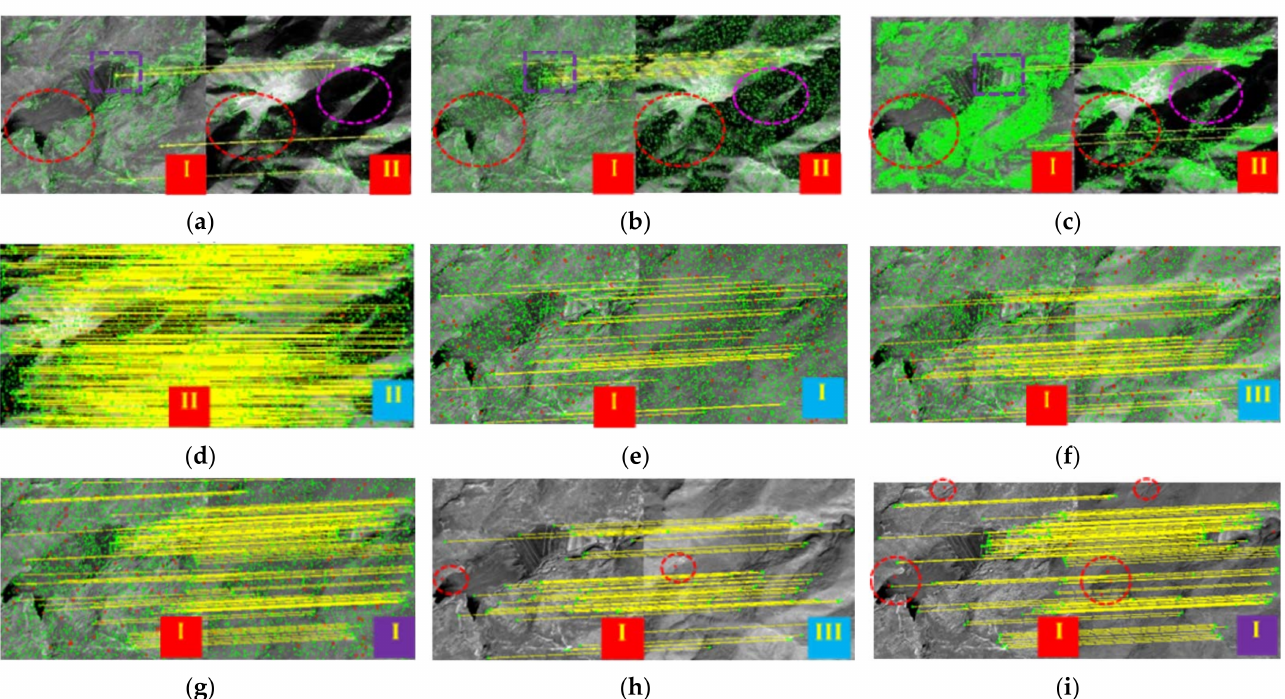
Figure 10. Feature extraction and matching results of local original image (950 × 1100 pixels) and stable feature image of mine production area. The feature algorithms used are ( a ) SURF, ( b ) SIFT, ( c ) ORB, and ( d – i ) SIFT. ( h ) and ( i ) filtered the inner points again by MOF. The roman numeral in the lower right corner is the image number, which corresponds to the image with the same number and background color as in Figure